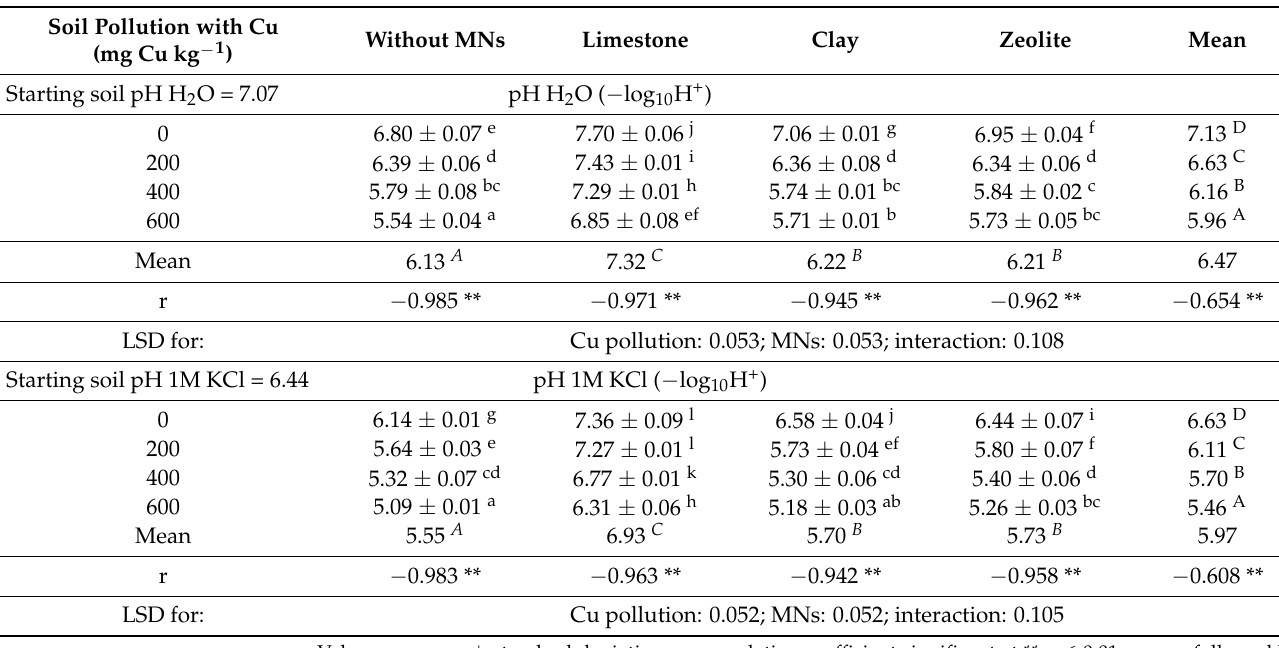
Table 1. pH of soil after black mustard ( Brassica nigra L. Koch)